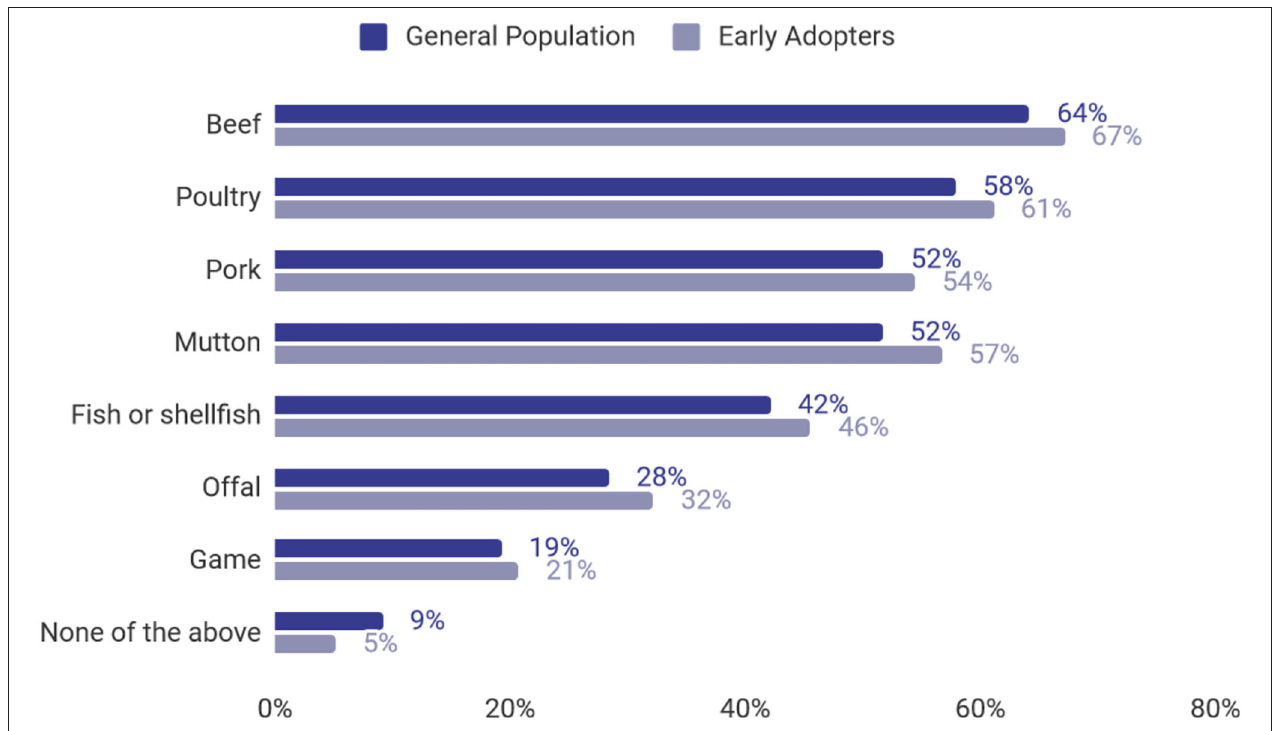
FIGURE 13 | Appeal of plant-based meat